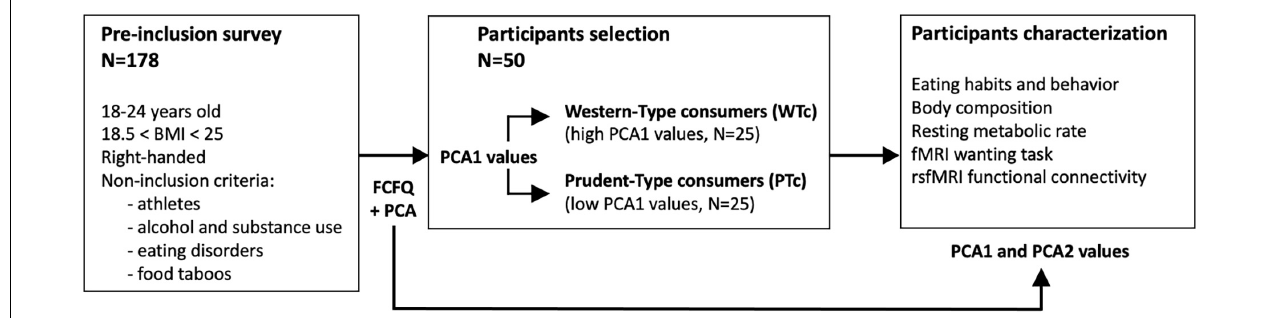
FIGURE 1 | Overall study design. With the principal component analysis (PCA) performed on the Food Frequency Questionnaire (FCFQ) data obtained from 178 volunteers, 50 participants were selected by the values of the first PCA axis (PCA1) that discriminated Western-type from prudent-type consumers (WTc, with high PCA1 values vs. PTc, with low PCA1 values). The first two axes of the PCA (PCA1 and PCA2) were used to further characterize the 50 selected